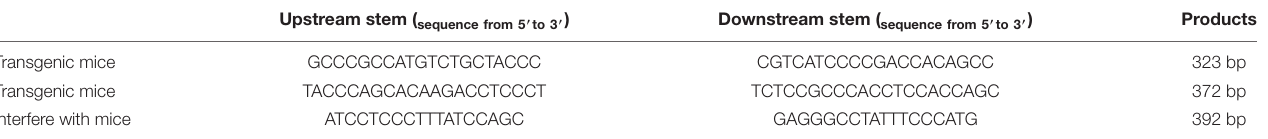
TABLE 2 | Sequences of primers used in this study.